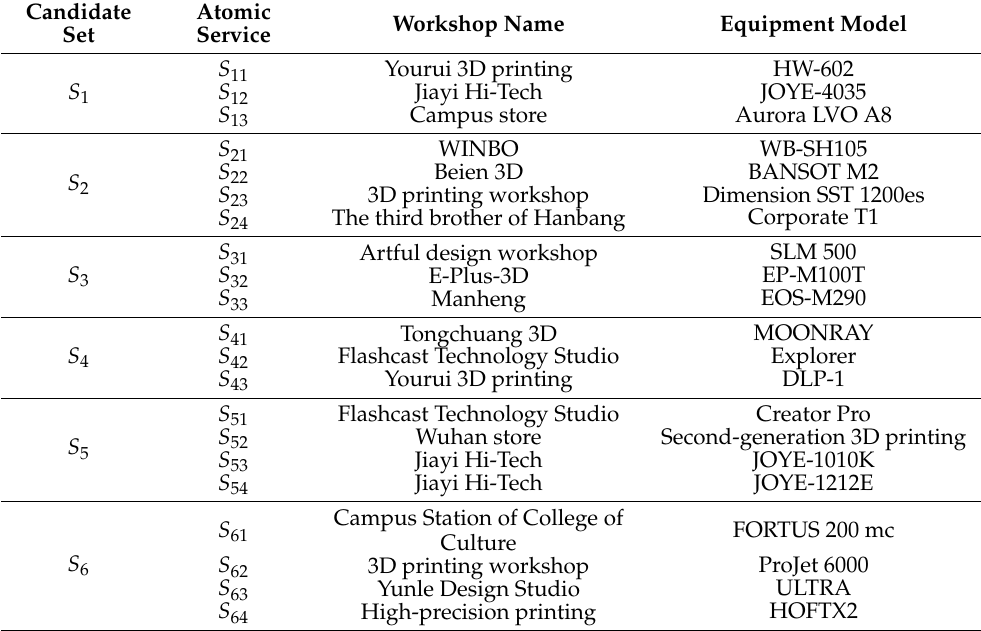
Table 5. Candidates for 3D printing device resources.